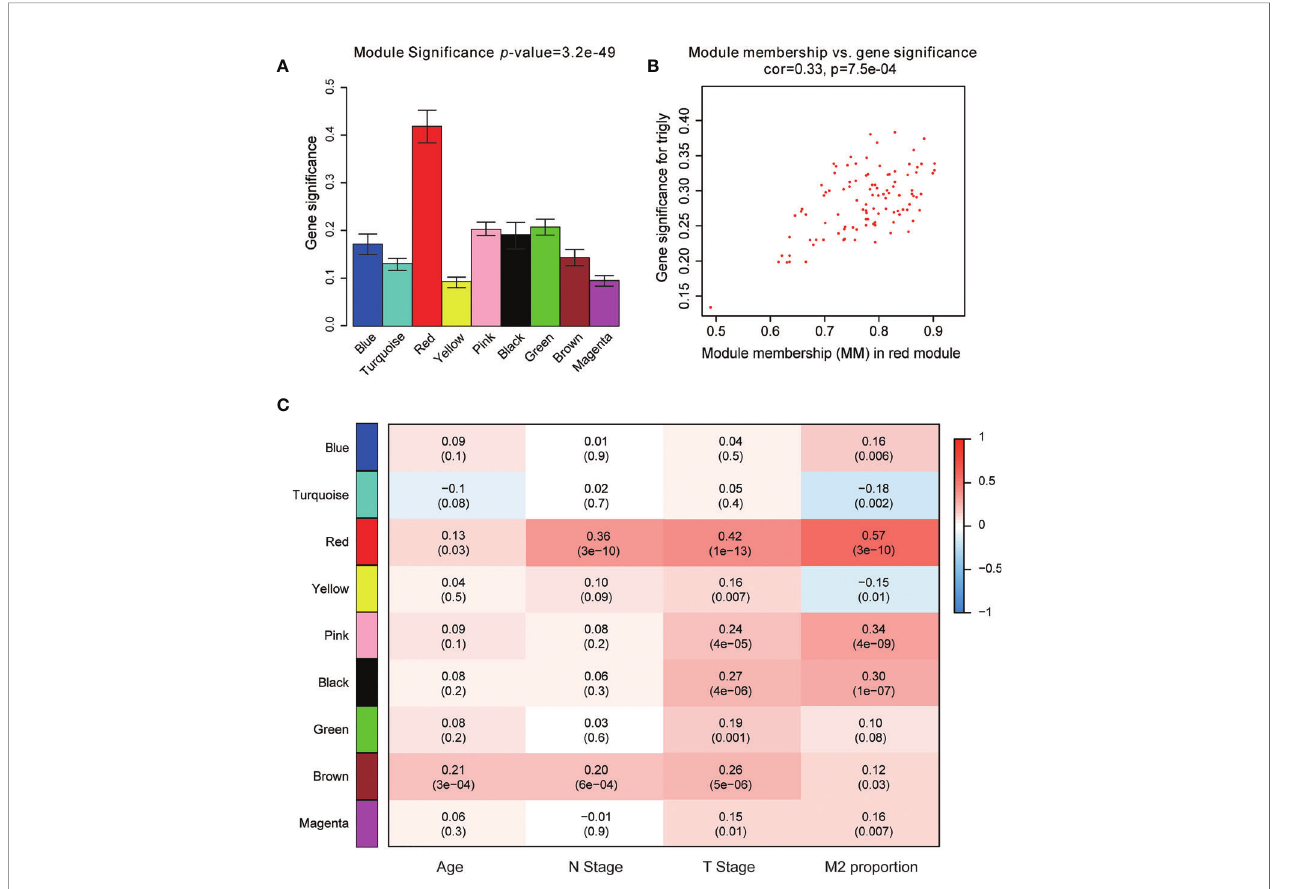
FIGURE 4 | Identi fi cation of modules associated with clinical characteristics. (A) Distribution of average gene signi fi cance and errors in the modules associated with the proportion of M2-TAMs in PCa; (B) Scatter plot of module eigengenes in red module; (C) Heatmap of the correlation between module eigengenes and different clinical characteristics of